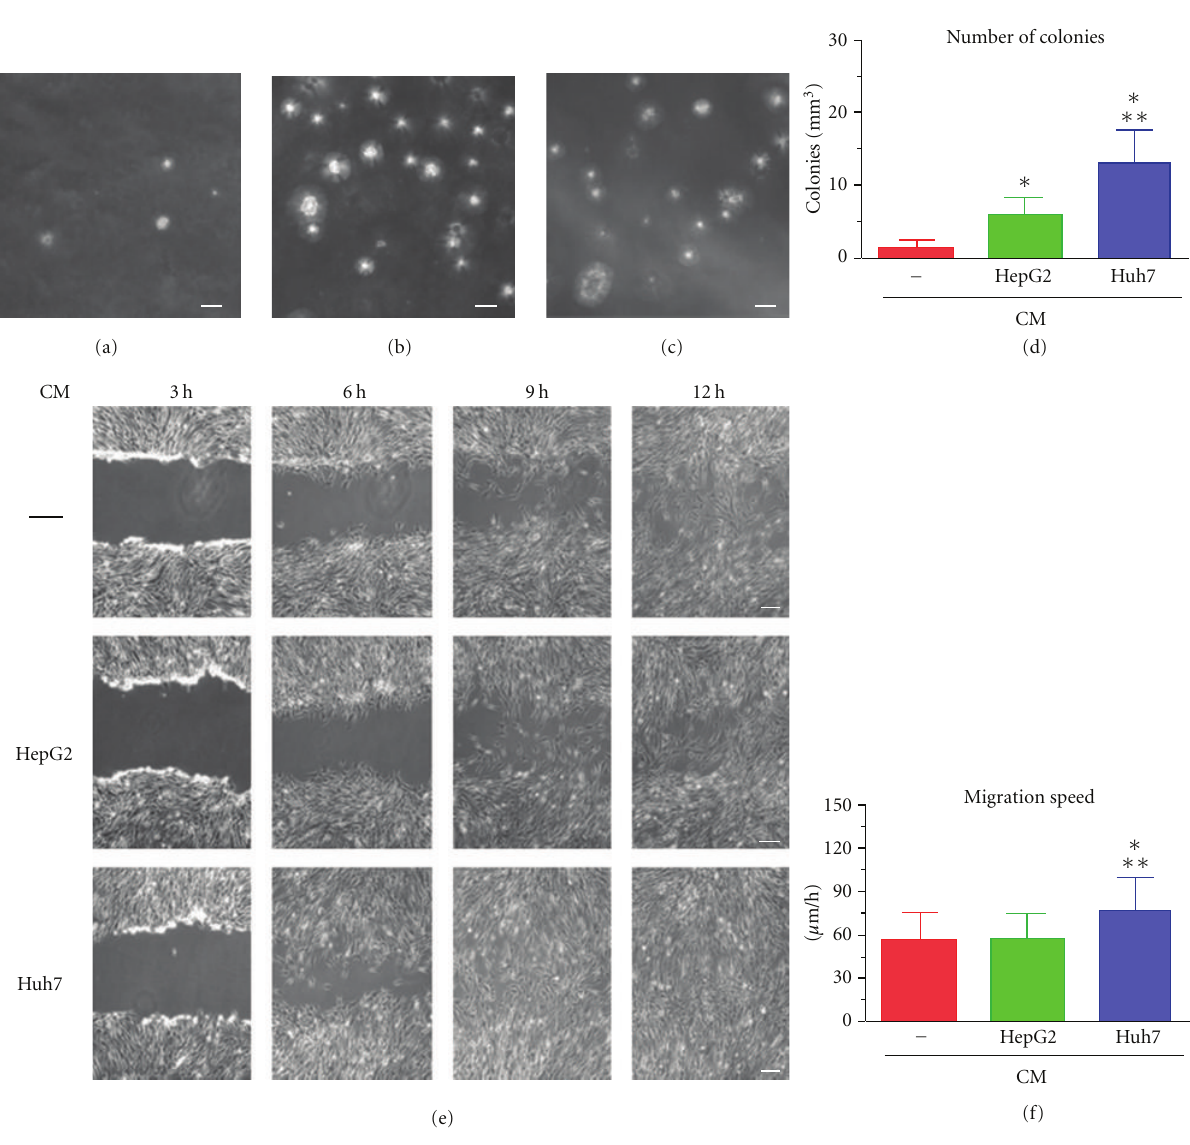
Figure 6: L-MASCs cultured in the presence of tumor-conditioned medium modify their growth characteristics. (a–d) Anchorage independent growth (soft agar assay) . Phase contrast images of the colonies formed by L-MASCs grown in non-CM (a), HepG2-CM (b), and Huh7-CM (c). Scale bar = 100 μ m. Results are expressed as mean ± S.D. ∗ , ∗∗ P < 0 . 05 versus non-CM and HepG2-CM, respectively (d). (e–f) Migration ability (scratch assay). Phase contrast images of three scratches produced in L-MASCs grown in non-CM, HepG2-CM, and Huh7-CM, respectively, taken at di ff erent time points. Scale bar = 50 μ m. Results are expressed as mean ± S.D. ∗ , ∗∗ P < 0 . 05 versus non-CM and HepG2-CM, respectively